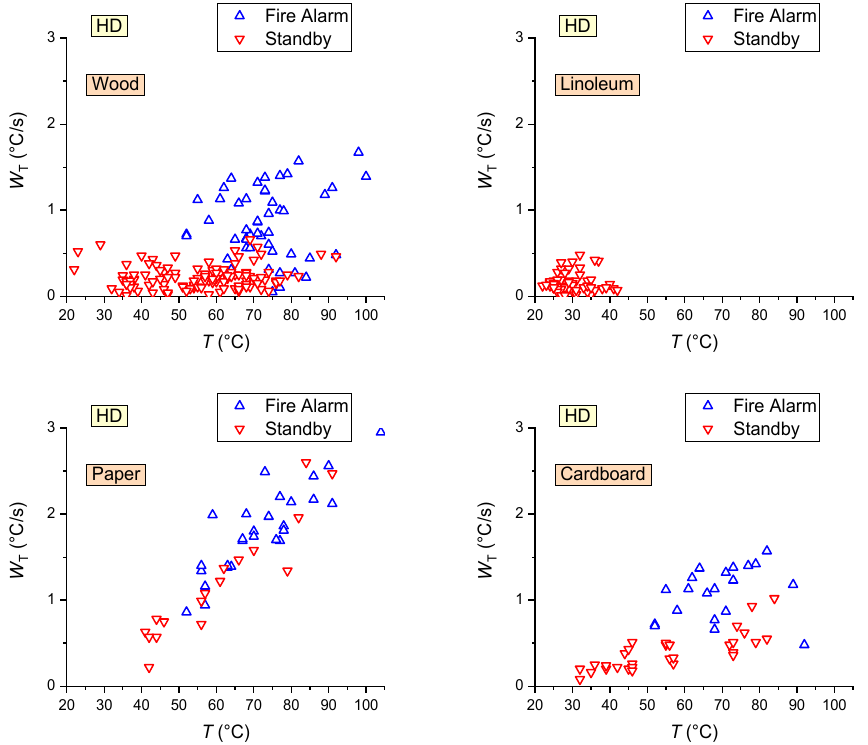
27 of 39 Figure 15. Summary map of FD activation/activation failure (all the results obtained during wood combustion were used). The results obtained during wood combustion were used (Figure 15). It was established that at a flame height of 1–2 cm, the FDs employed in the experiments were not activated in most cases. When the flame detector was moved away to a distance of 1–6 m from the fire, the flame height necessary for detector activation was found to increase nonlinearly to 2–25 cm. Overall, the experimental findings indicate that the constructed map for detector activation/activation failure (Figure 15) should be applied